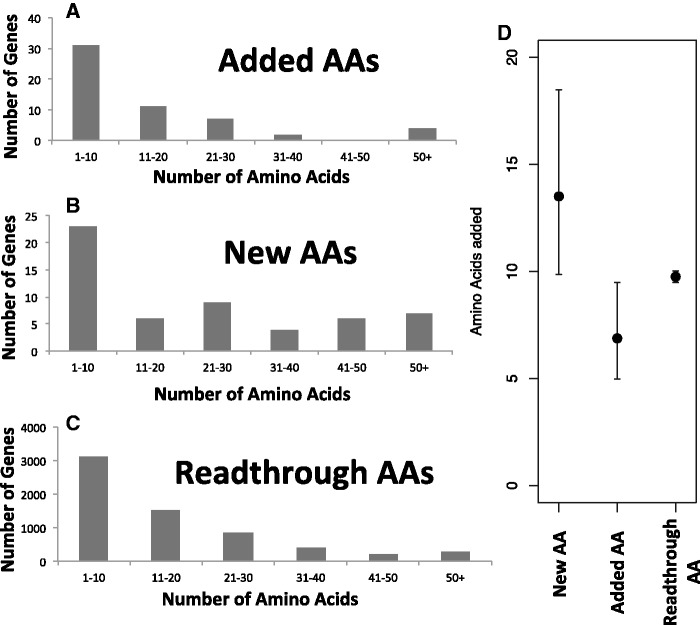
The frequencies of C-terminal extension lengths per gene within S. cerevisiae and S. paradoxus. See figure 1 for the distinction between added (A) and new (B) amino acids. The “readthrough” histogram (C) is based on the number of amino acids that would be added to a gene if the stop codon were removed and translation were to read through to the next in-frame stop codon. Genes that did not reach a stop codon prior to the end of their UTR boundary as predicted by Nagalakshmi et al. (2008) were excluded. (D) The geometric mean and 95% confidence interval for added, new, and readthrough amino acid distributions. Data were approximately normal or truncated normal following a log transformation, so this transformation was used for statistics, with figure 4D generated through a back transformation. Added sequences are shorter than readthrough controls (P = 0.035; two-tailed t-test on transformed data). The still greater length of new amino acid sequences results from a statistical artifact; for many frameshifts that created smaller numbers of new amino acids, an early stop codon, earlier than the ancestral stop codon, would have prevented inclusion in our data set.